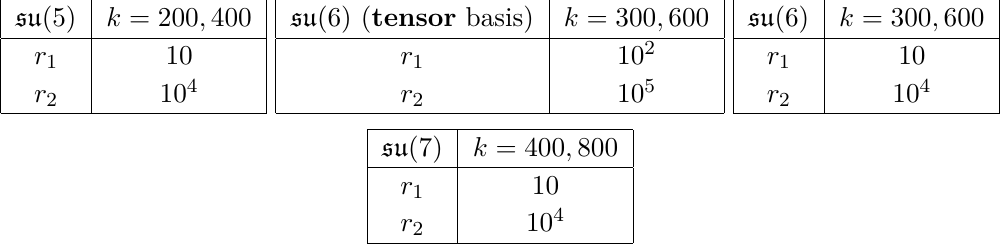
Table 1 . The scaling factors for L 24 .